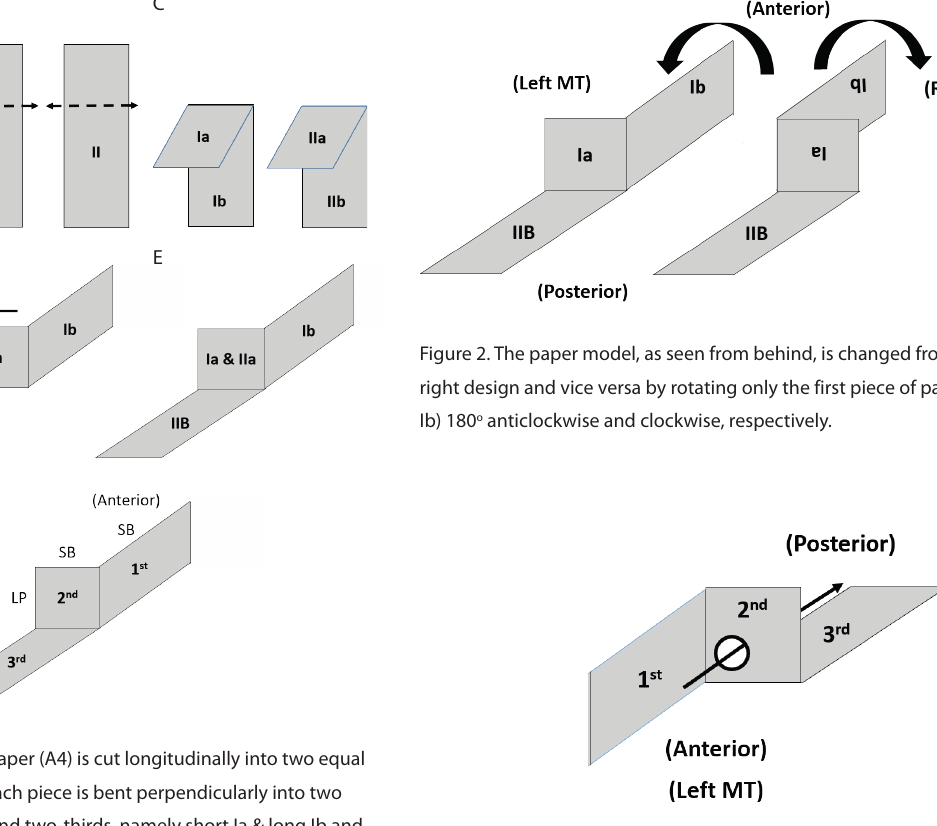
Figure 3. The left basal lamella, visualized from front, is opened inferior and medial which is the safest location. This is away from the superior skull base and lateral lamina